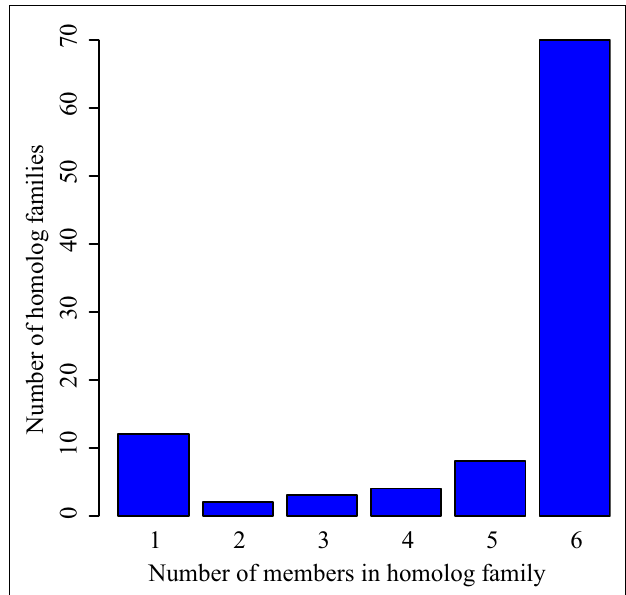
FIGURE 2 | Conservation of C/D box sRNA genes among six Pyrobaculum genomes. C/D box sRNA genes were organized by homolog family based on the location targeted by the encoded guide regions.These homolog families were then compared among the six studied species to verify conservation.While each individual species encodes more than 74 C/D box sRNA genes, 70 of those are conserved among each of the six studied Pyrobaculum spp. (group